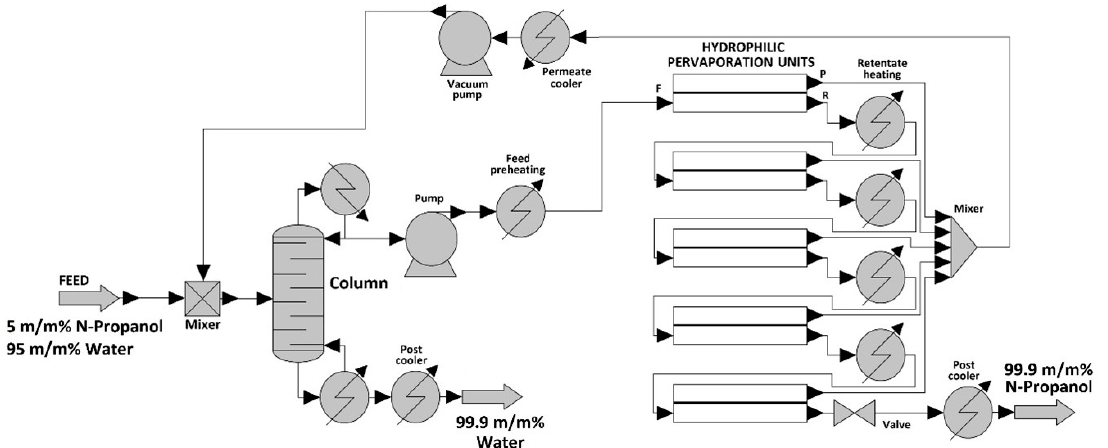
Figure 3 . Simulated hybrid distillation and hydrophilic pervaporation method for separating n-pro- panol–water binary mixture. propanol–water binary